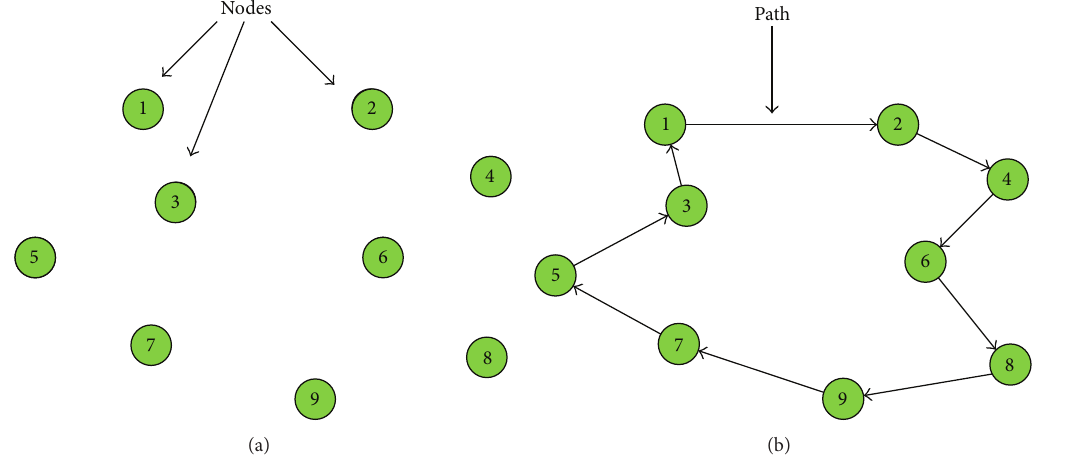
Figure 1: Example of TSP instance and possible